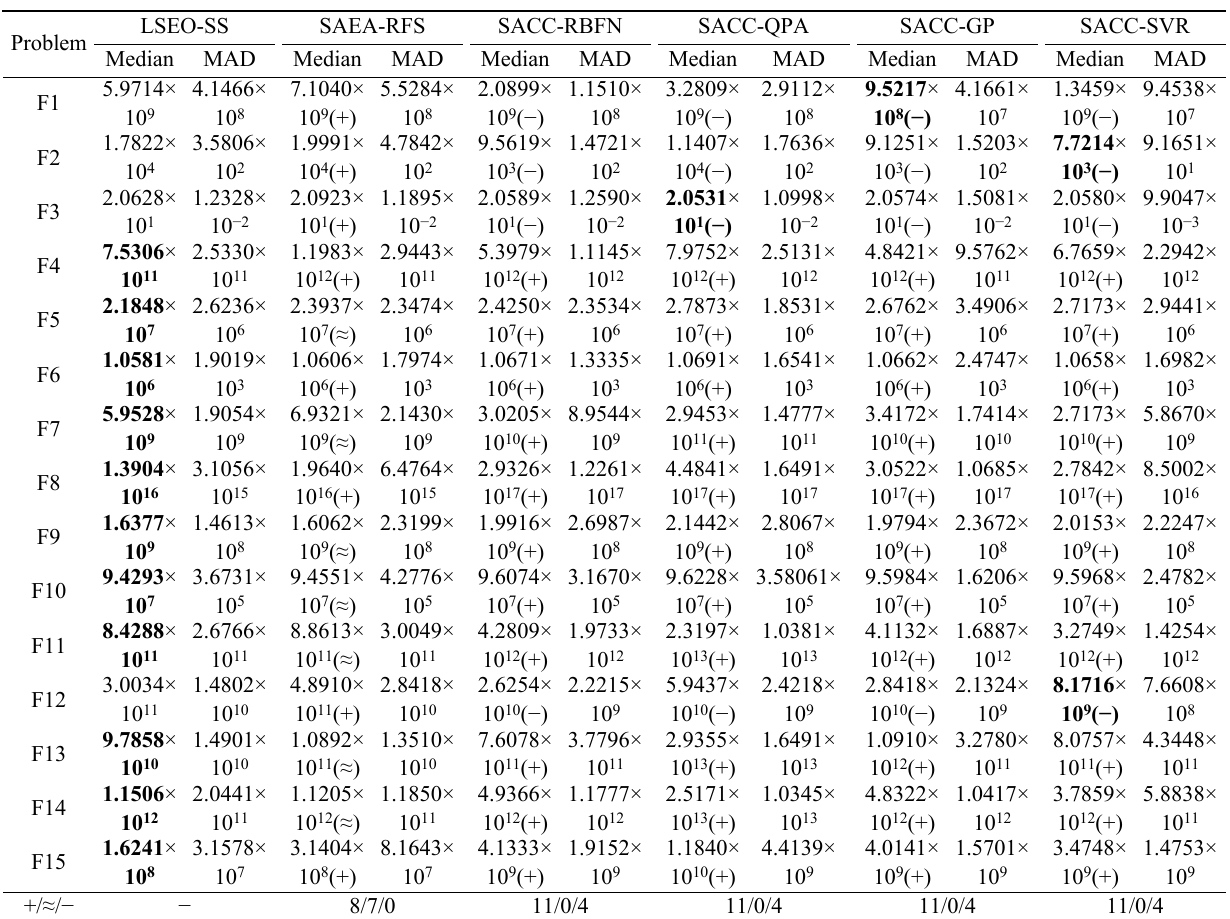
Table 5 Statistical results of the optimal objective values, given in median and median absolute deviation (MAD), on CEC’ 2013 benchmark problems obtained by different